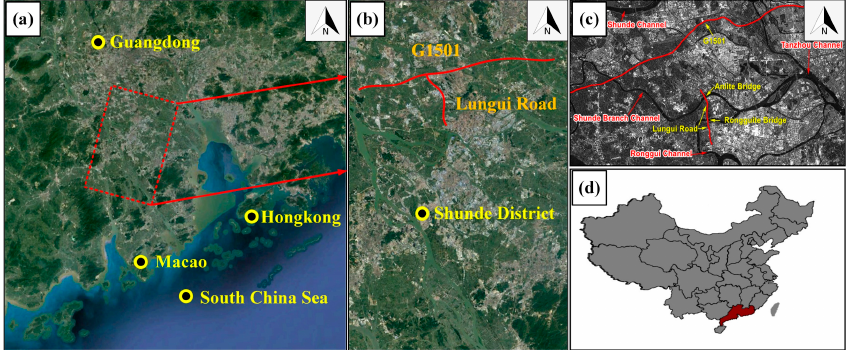
Figure 2. Study area featured at different scales: ( a ) Optical image. The red rectangle defines the spatial coverage of the TerraSAR-X images in our experiment; ( b,c ) Highway region of interest outlined in red solid lines; ( d ) Location in China.